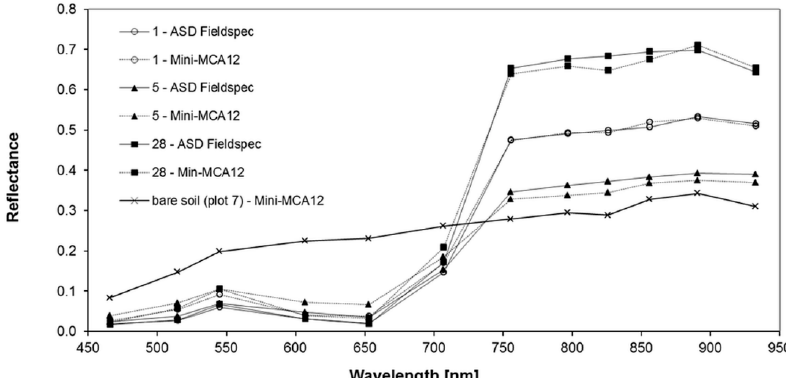
Figure 14. Comparison of the spectral response of lucerne extracted from calibrated Mini-MCA 12 bands with ground measured ASD Fieldspec reflectance and with bare soil reflectance (extracted from calibrated Mini-MCA 12 bands; ASD Fieldspec reflectance not available). The selected sites represent high (28), medium (1) and low (5) amounts of fresh phytomass of lucerne. The bare soil spectrum represents an area free of vegetation within plot 7.